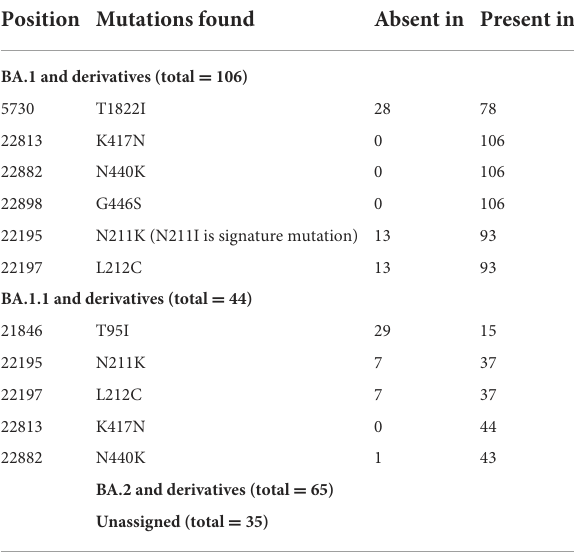
TABLE 3 Unique mutations detected in Omicron